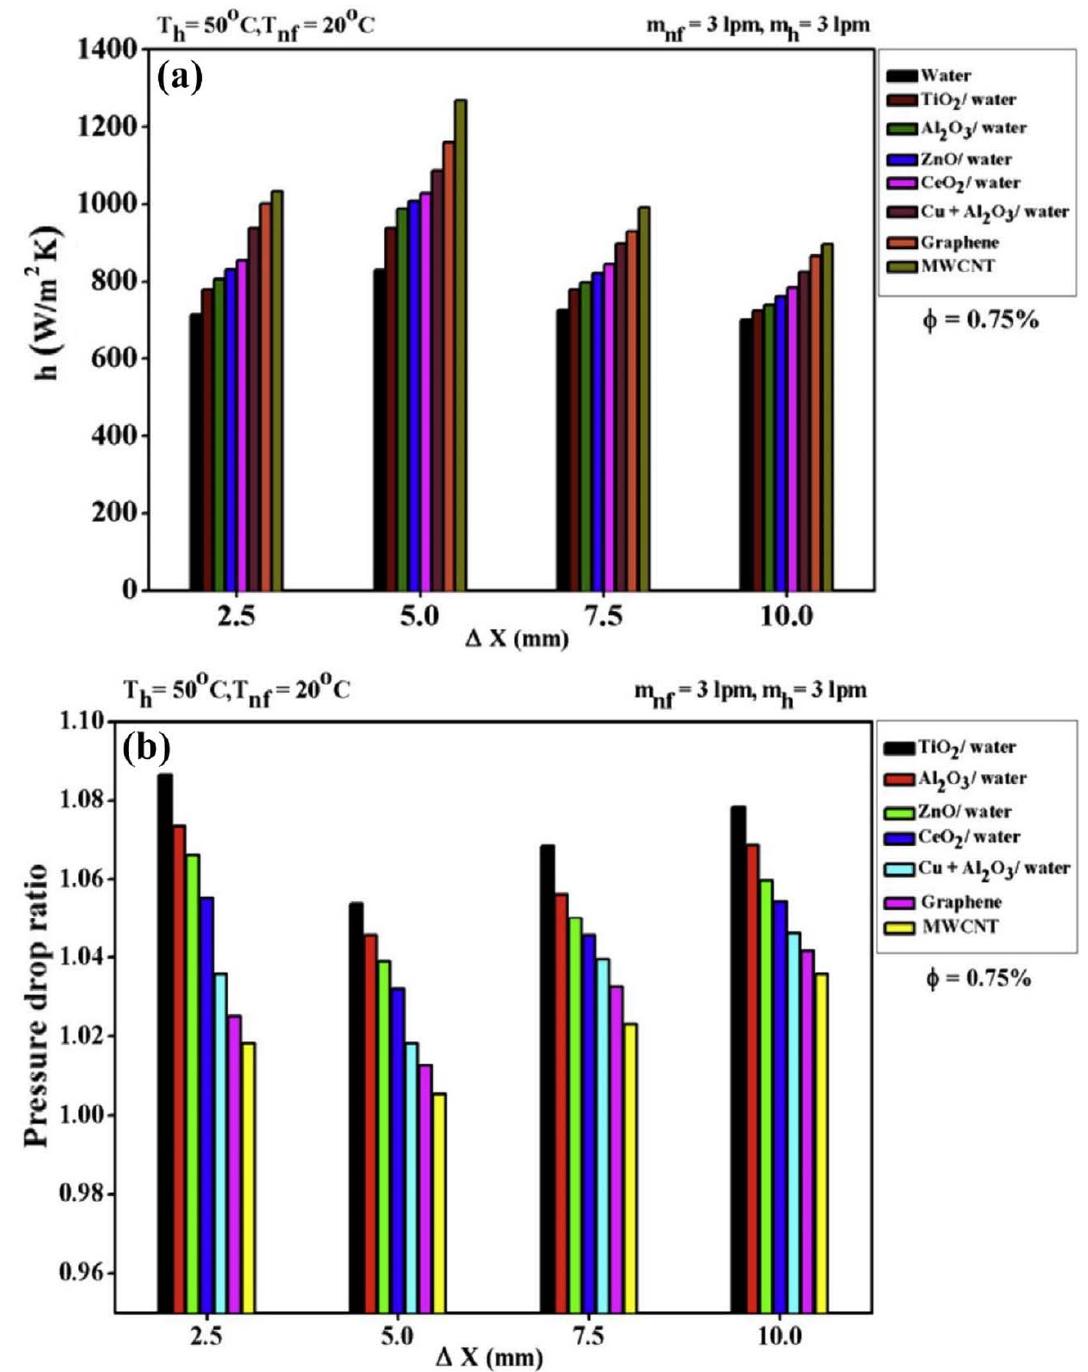
Figure 13. Variations of ( a ) the convective heat transfer coefficient, and ( b ) pressure drop versus the spacing value at the solid concentration of 0.75 vol. %. Reproduced with permission from [183]. Elsevier, 2016.